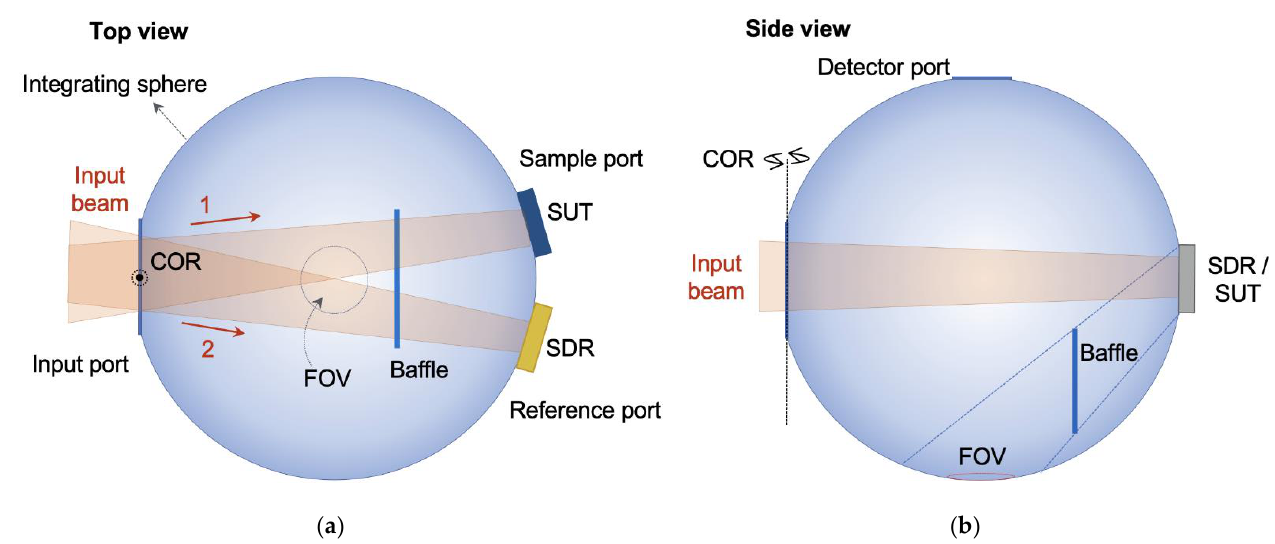
Figure 3. ( a ) Top view and ( b ) side view schematics of the relative reflectometer integrating sphere. (FOV: field of view, SUT: sample under test, SDR: standard diffuse reflector, COR: center of rotation).